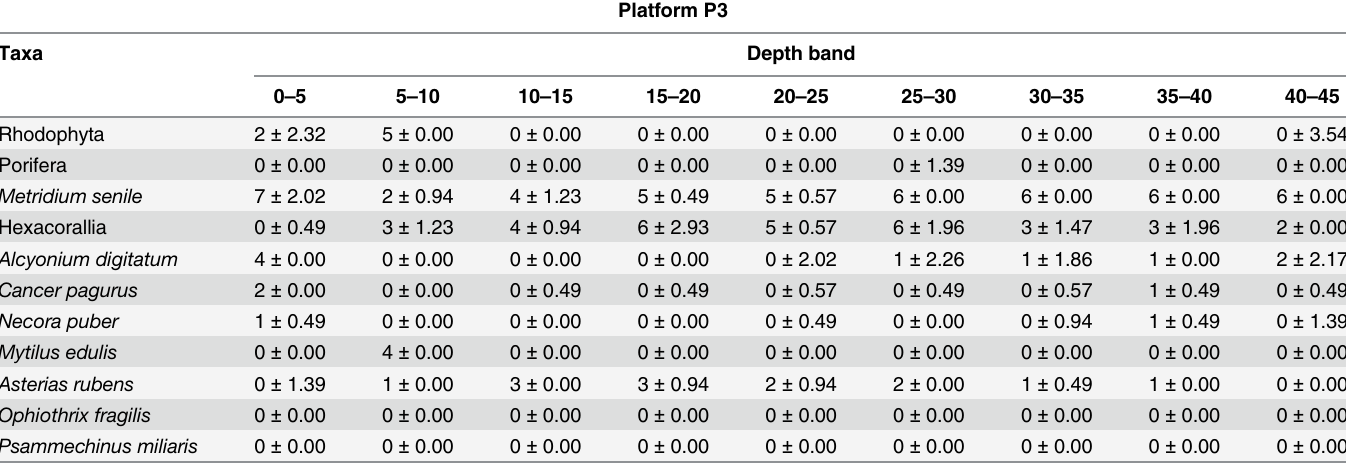
Table 6. Averaged categorised abundance of the 11 high detectable taxa, with 95% confidence interval around the mean, per depth band on plat- form P3.